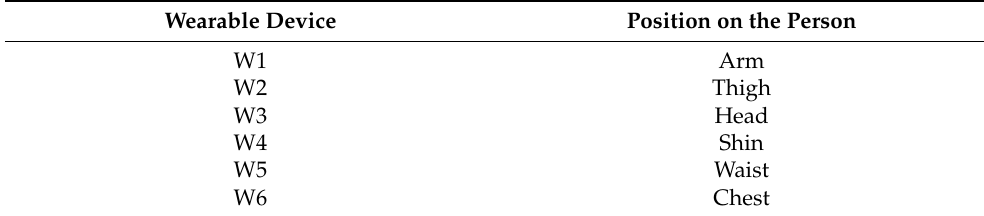
Table 1. Position of the wearable devices over the